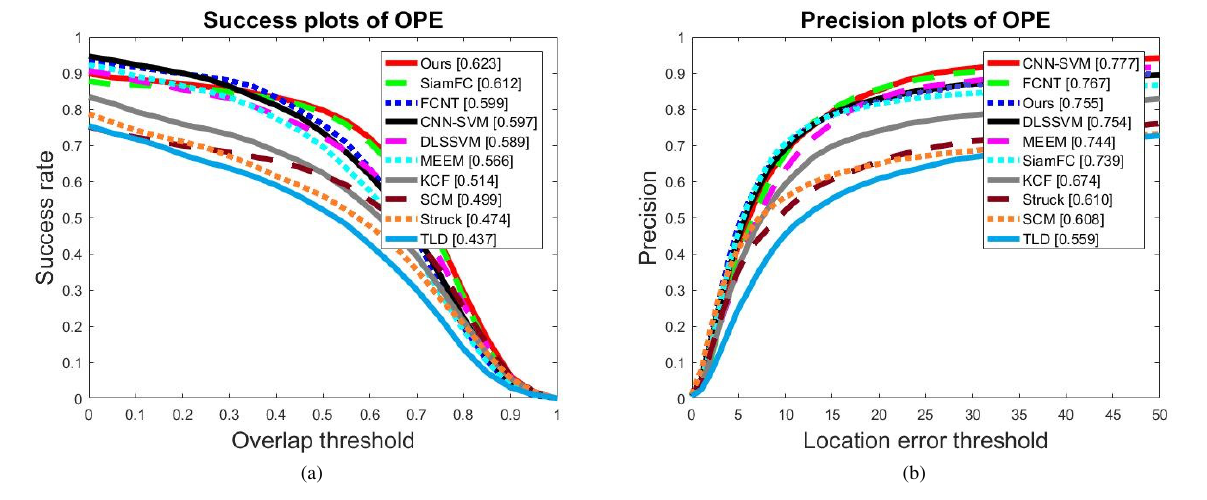
Figure 8. Average success plot (left) and precision plot (right) for the OPE on TB50.